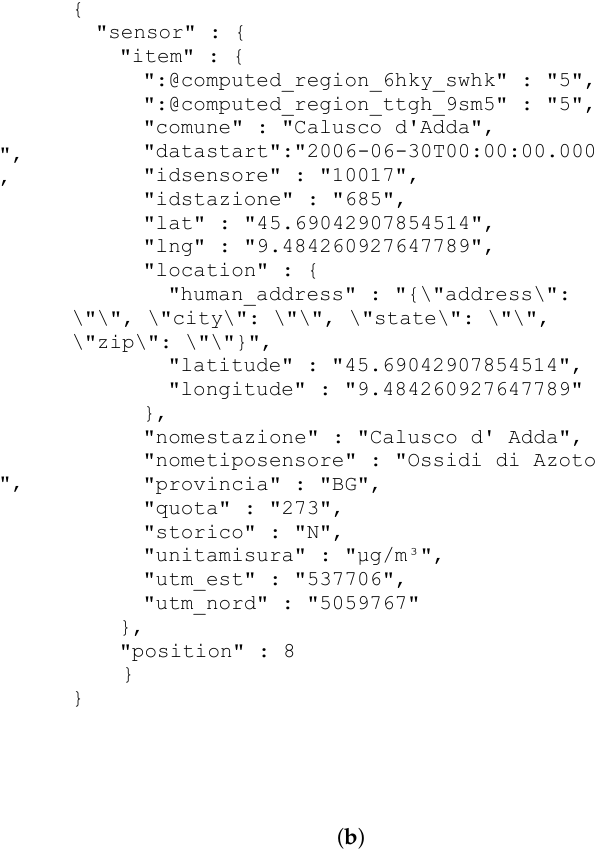
Figure 6. Example of a document in the temporary collection generated by line 7 ( a ) and by line 8 ( b ). ( a ) Excerpt of the beginning of the document obtained from the portal with data about air-quality sensors. ( b ) Example of a document obtained after unnesting documents received from the portal about air-quality